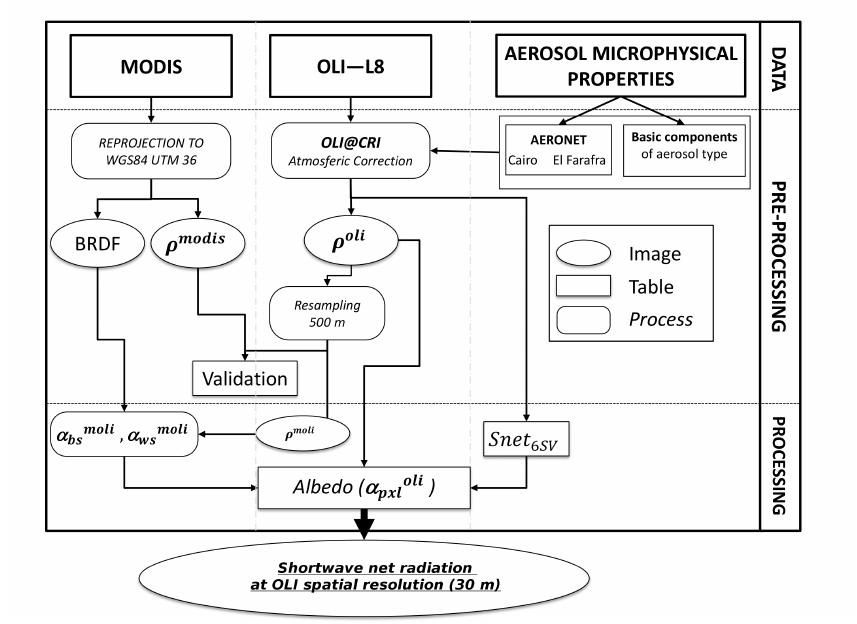
Figure 3. Processing chain for retrieval of the R n . sw at OLI spatial